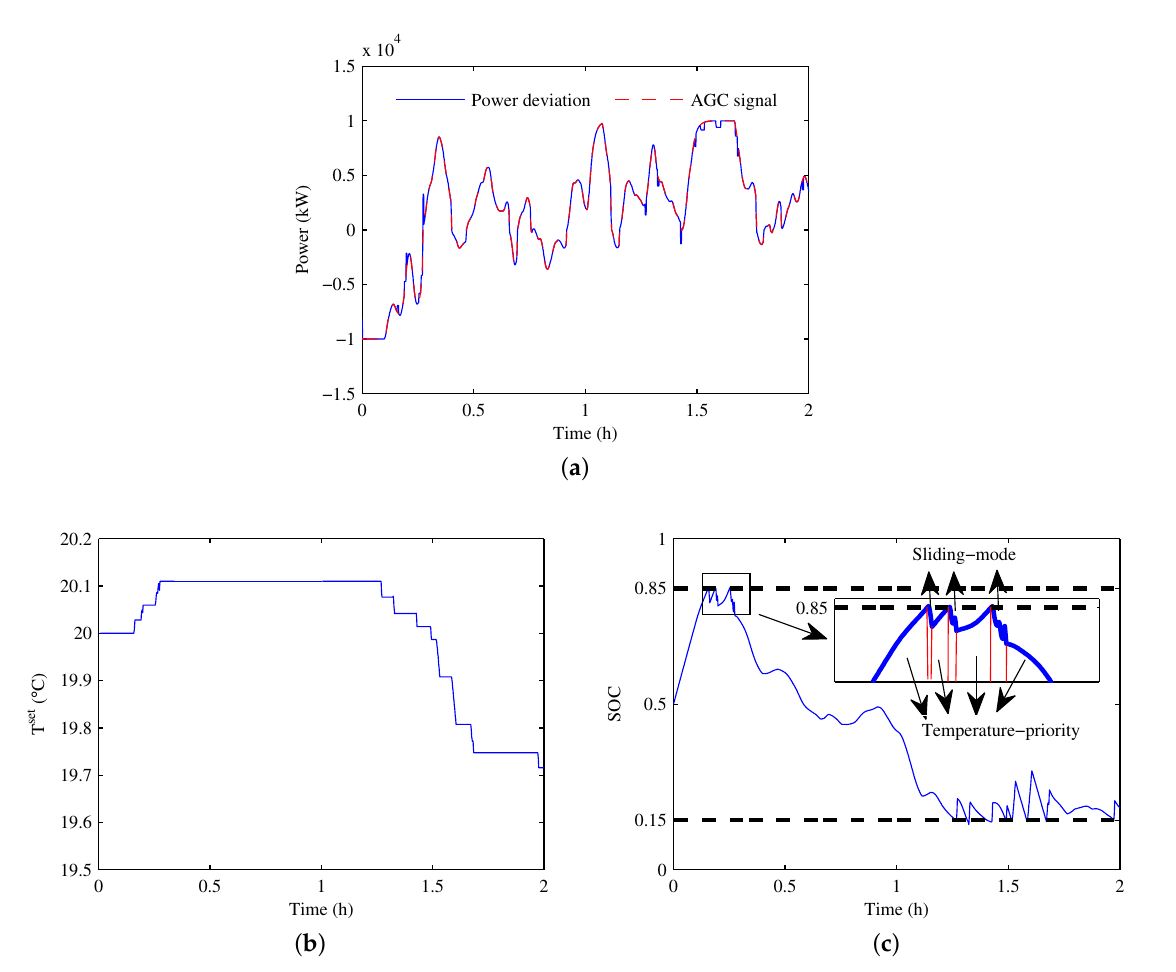
Figure 8. ( a ) AGC signal tracking; ( b ) temperature setpoint trajectory; ( c ) SOC of Switched Control I.